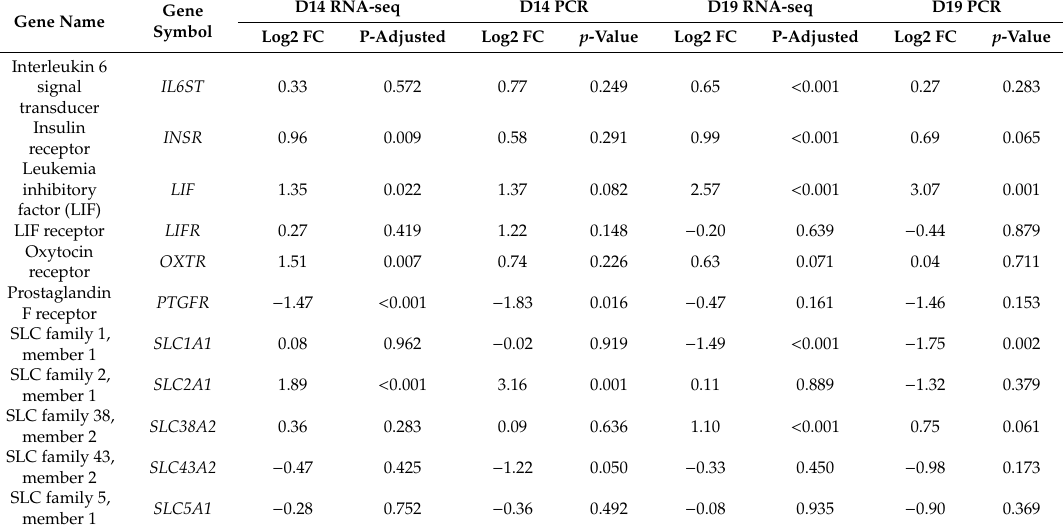
Table 2. Validation of the RNA-seq results by qRT-PCR for selected genes in the equine endometrium 6 (day 14) and 11 (day 19) days after transfer of day 8 embryos to the uterus of mares on day 8 (synchronous) or day 3 (asynchronous) after ovulation. Day 14 synchronous vs. asynchronous and day 19 synchronous vs. asynchronous. Positive values represent upregulated genes, and negative values represent downregulated genes in synchronous endometrium. Solute carrier: SLC; fold change: FC.